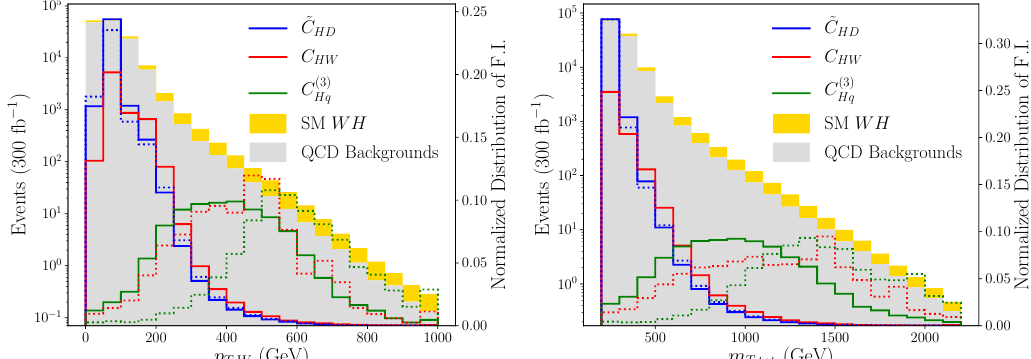
Figure 3 . Left axis: stacked histograms of the SM signal on top of the QCD backgrounds for p T;W (left) and m T; tot (right). Right axis: normalized distributions of the diagonal elements of the Fisher information, representing the information on the three Wilson coe(cid:14)cients. The solid lines are linearized in the Wilson coe(cid:14)cients, while the dotted lines show the information on the dimension-6 squared